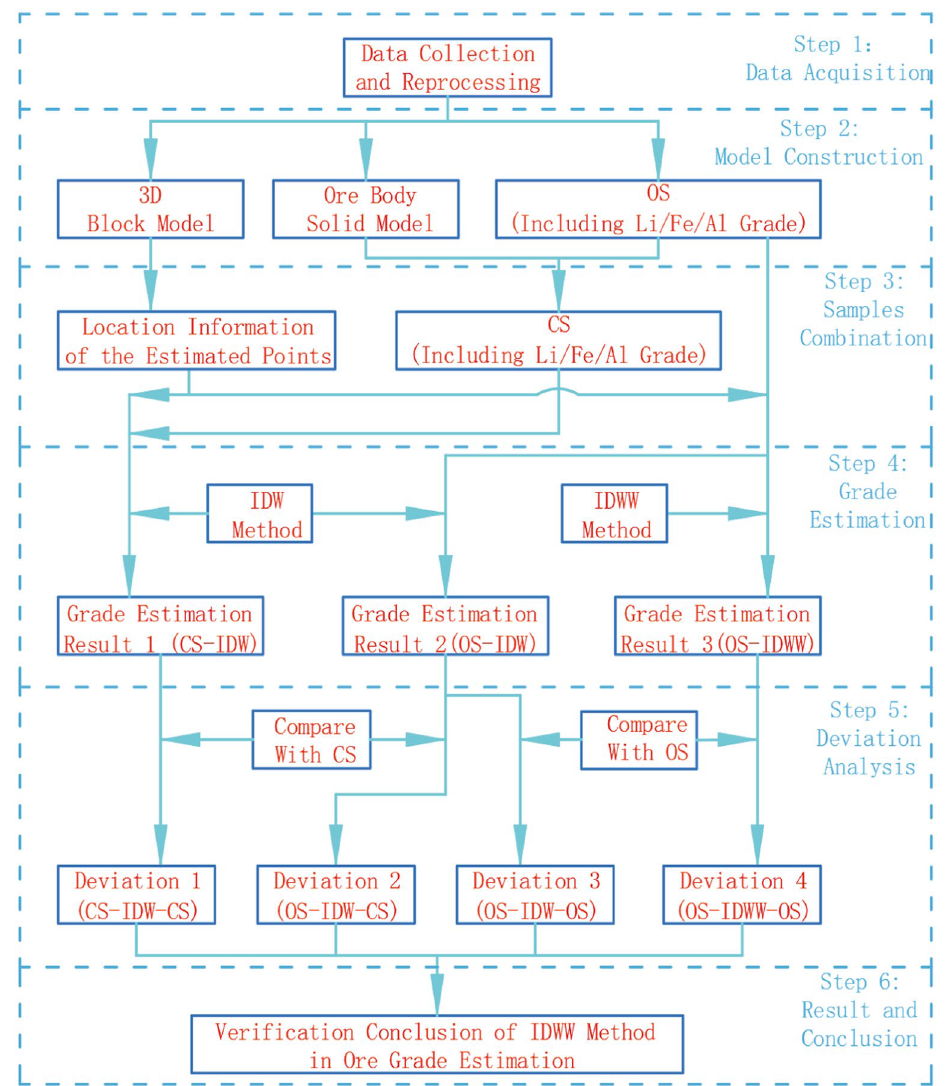
Figure 8. Study flow